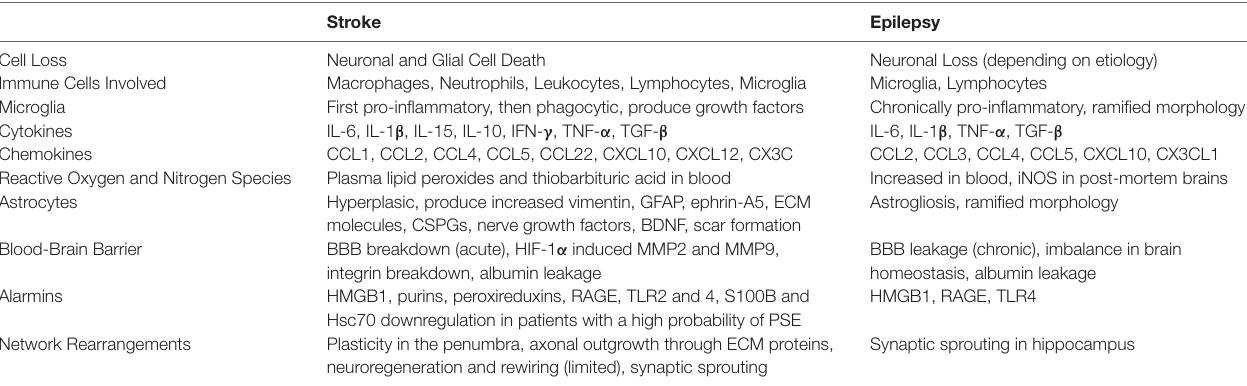
TABLE 1 | Summary of Inflammatory changes in stroke and